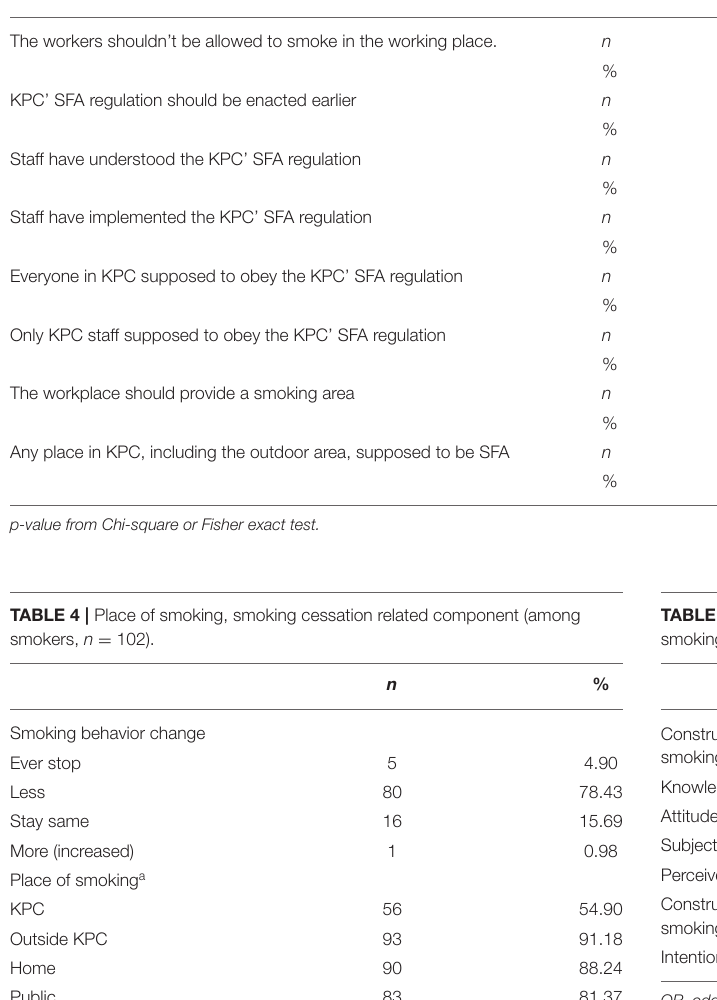
TABLE 3 | Respondents’ts’ views on policy implementation KPC’ SFA Regulation – percentage agreement for non-smokers and smokers, % Agreement (Strongly Agree/Agree), by smoking status ( n = 363). The workers shouldn’t be allowed to smoke in the working place.